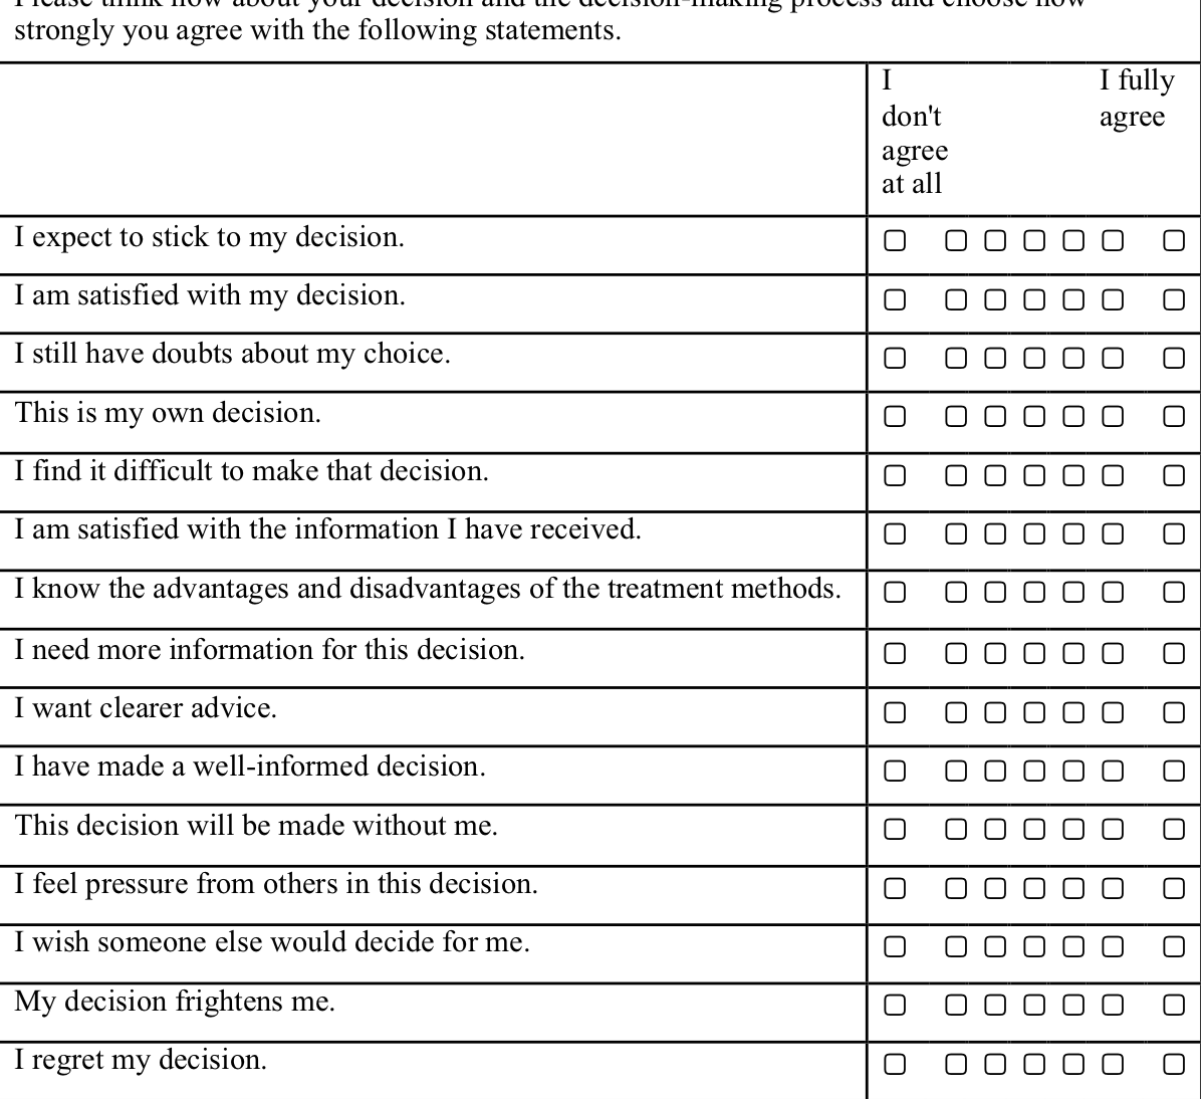
Figure 3. Decision evaluation